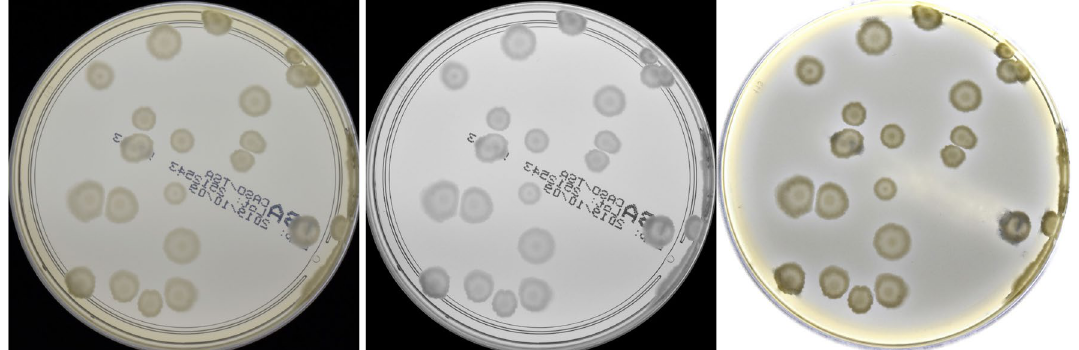
Figure 2. Removal of artifacts detected by thresholding in the CIELab colorspace ( luminance channel presented in the middle), and replaced by a nearest valid pixel found by a random walk.